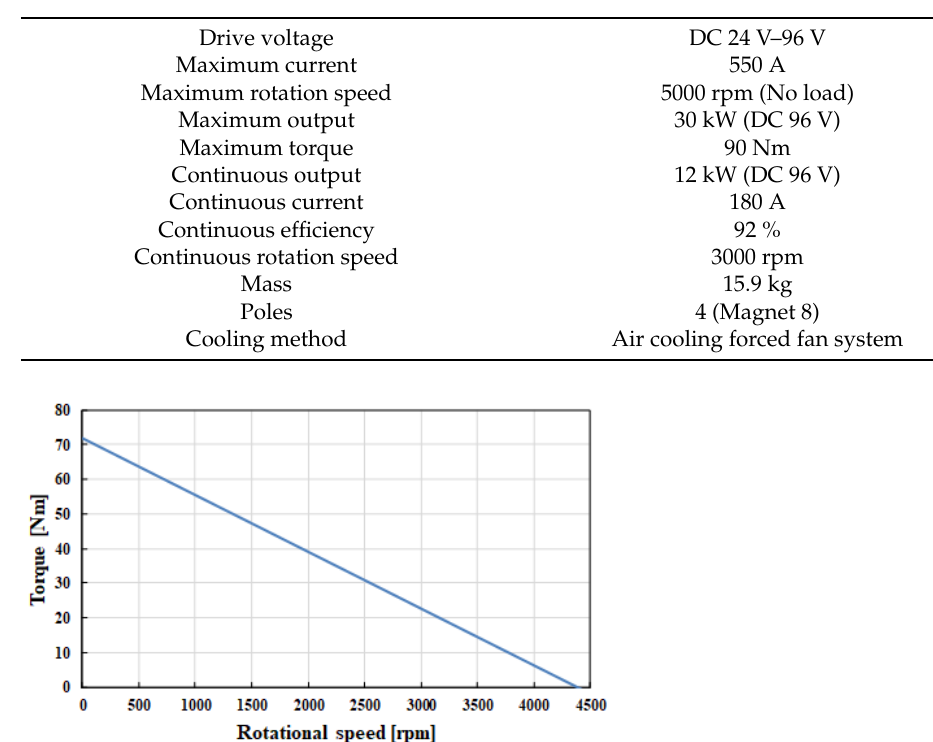
Figure 7. Electric motor Motenergy ME0913. Table 2. Specifications of the electric motor.